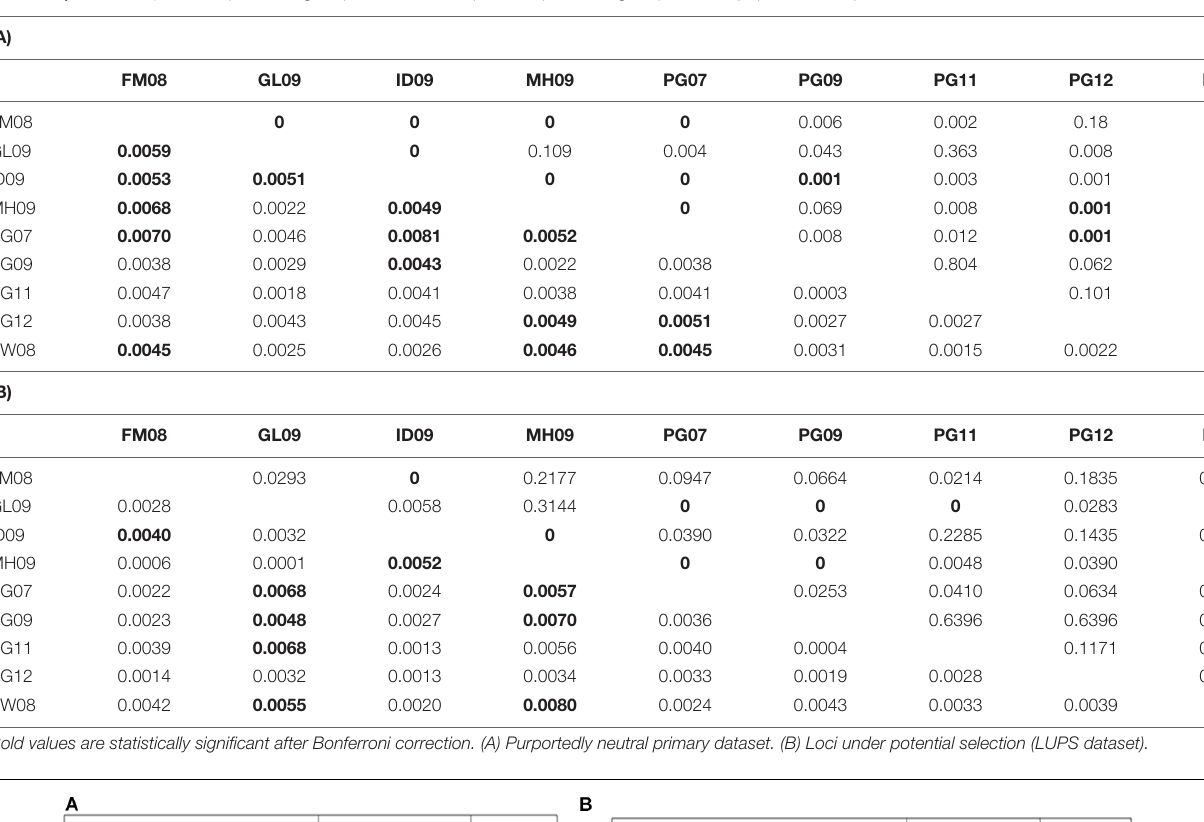
TABLE 3 | Pairwise F ST values (below diagonal) and associated p values (above diagonal) between population samples.